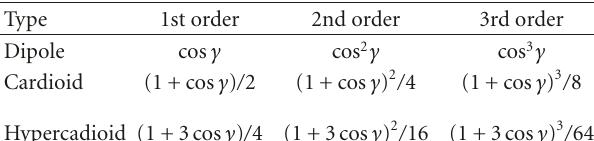
Table 2: Various directional array responses.